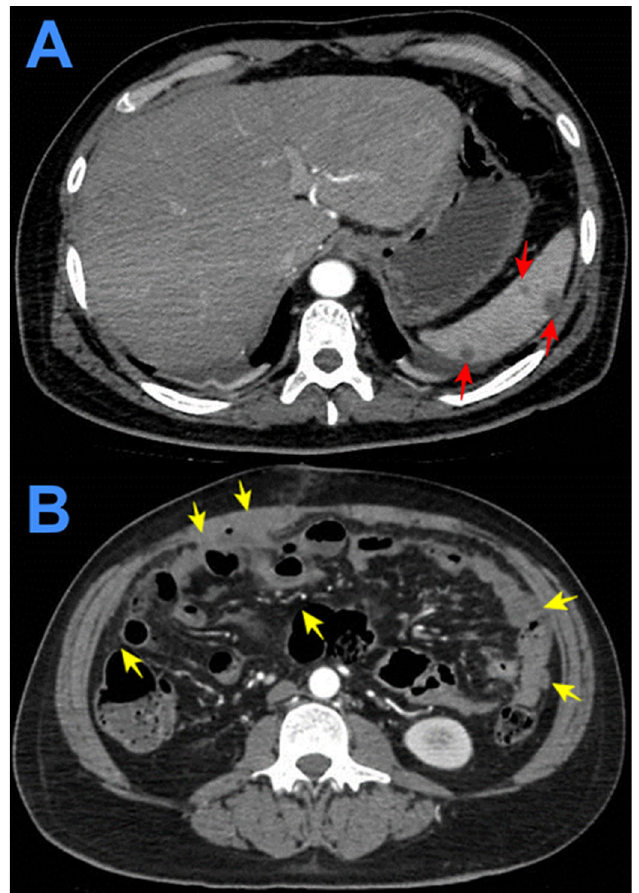
Figure 4. Contrast enhanced computed tomography showing solid focal hypodense areas of <20 mm in diameter that do not enhance with contrast (A). Diffuse thickening of parietal peritoneum with multiple hypodensenodularimplantswithwell-definedborders;inflammatorychangesinbothiliacfosses;andscarce free fluid in the paracolic gutters and paravesical spaces (B).